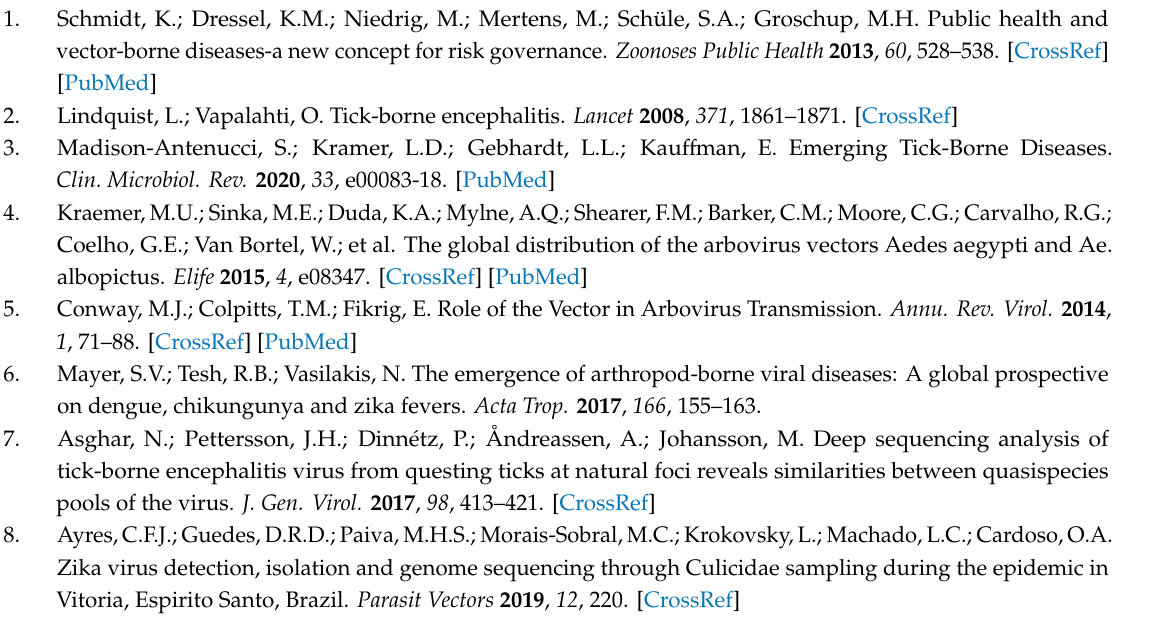
Table S1: Primers and probes used for detection of viral pathogens in the real time qPCR assay, Supplementary file S1: Detailed description of the developed extraction method ROVIV and mNGS workflow